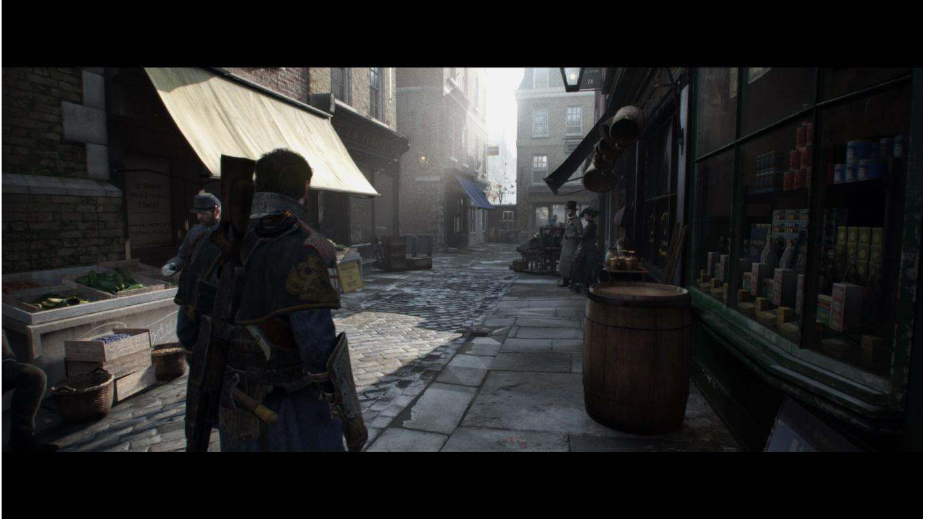
Figure 2: The rendition of a street in Victorian London in The Order